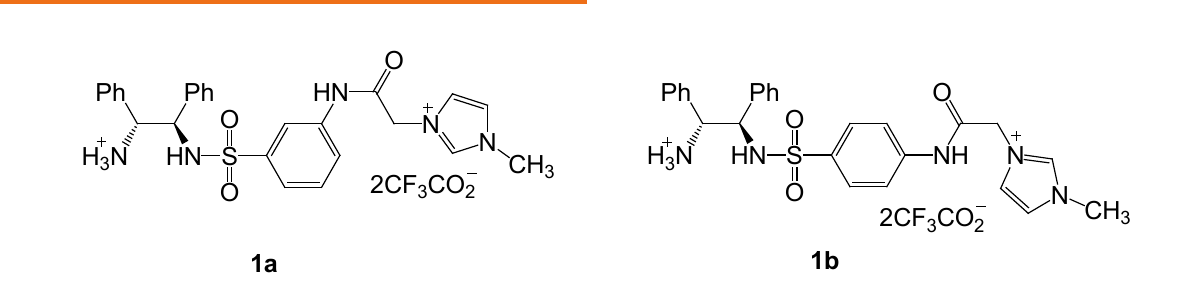
Figure 1. Chiral aminosulfonamides 1a and